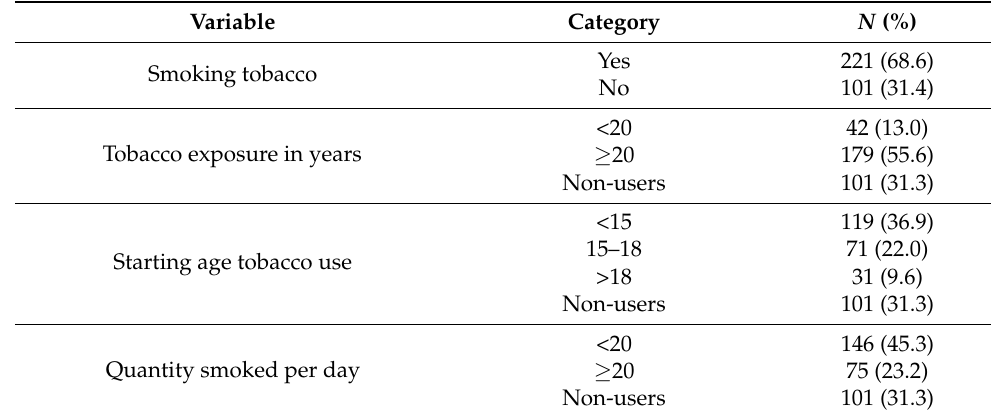
Table 2. Risk factors (tobacco/recreational drug/alcohol use) ( N =